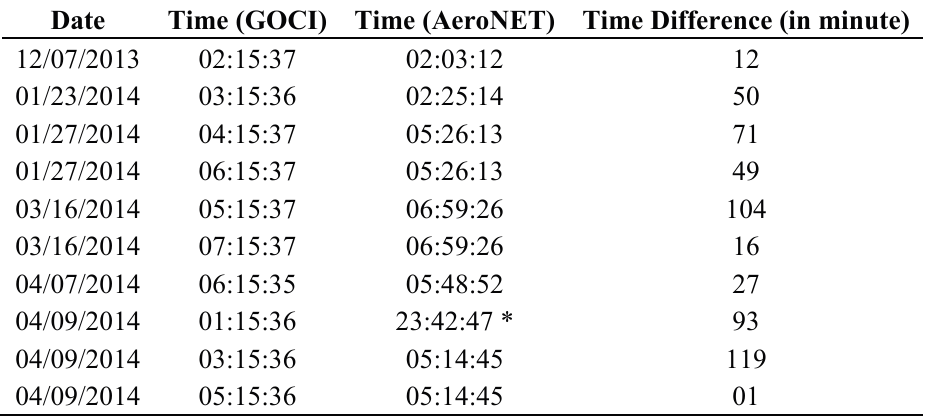
Table 1. Description of coincident AeroNET and GOCI ocean color data. For each date, the acquisition time (UTC) is indicated in